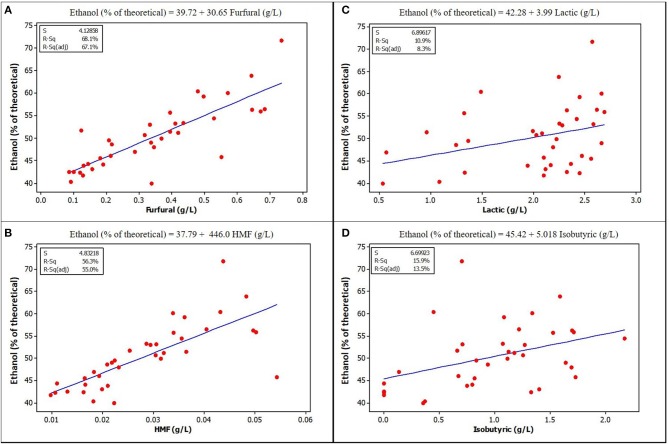
Relationships between ethanol yield and concentration of some potential inhibitors in the fermentation volume of ensiled stover. (A) Furfural (B) HMF [Lactic acid (C) and Isobutyric (D) are included because of their high concentration in ensiled samples, although they do not show obvious correlation with ethanol yield, p-values are also <0.05] See Supplementary Materials for correlation coefficients and p-values.